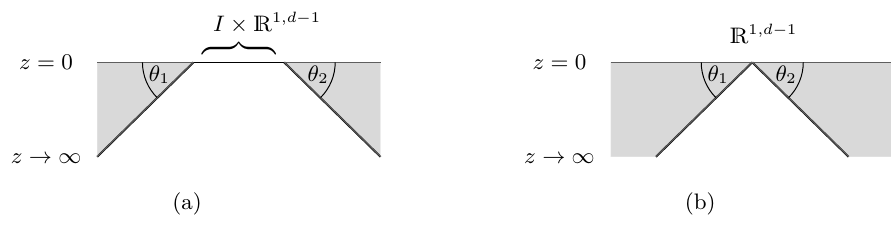
Figure 1 . Wedge holography from CFT d +1 on an interval. The R 1 ,d − 1 part has been suppressed. The conformal boundary on the left is the product of an interval and R 1 ,d − 1 ; on the right it is reduced to R 1 ,d − 1